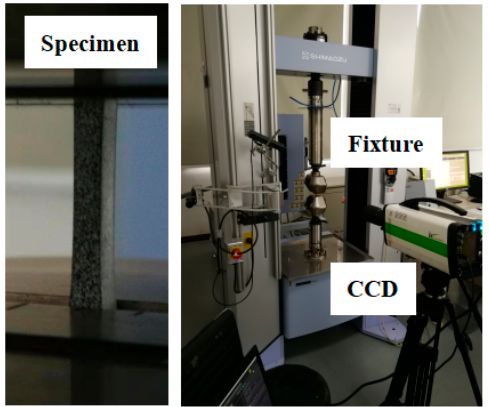
Figure 4. The tensile process and devices.